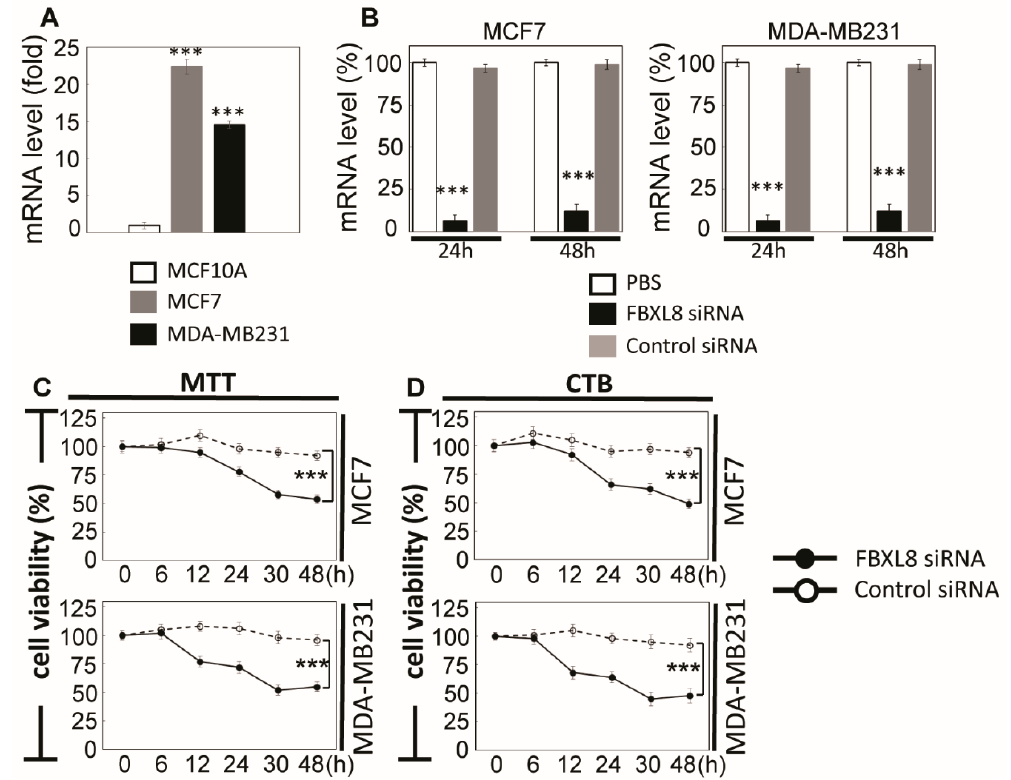
Figure 3. Cont Figure 3 . Cont.